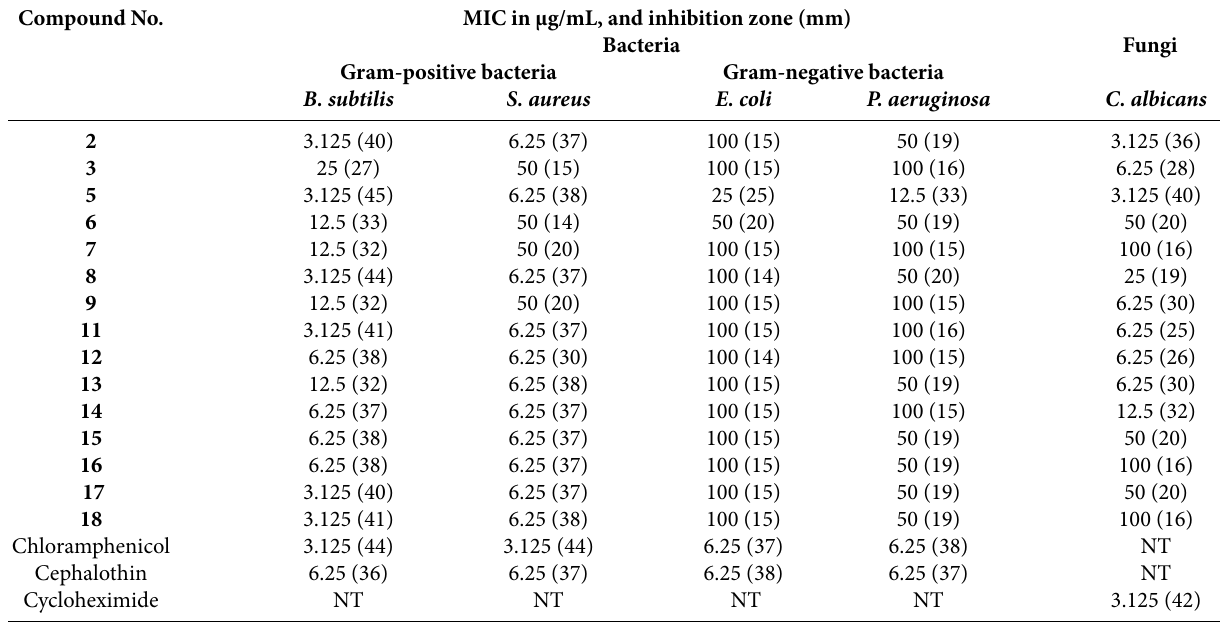
Table 1. Minimum inhibiton concentration (MIC, µg/mL) and inhibition zone (mm) of the synthesized compounds. Compound